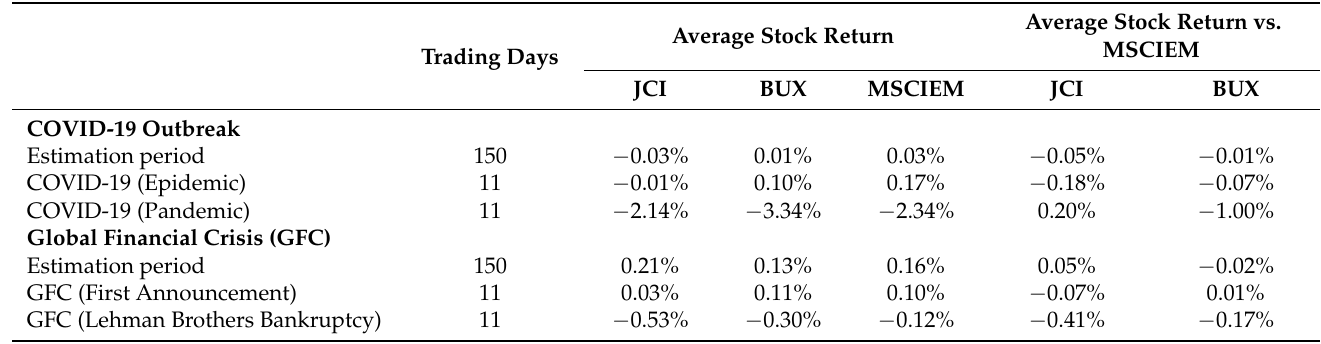
Table 3. The JCI and BUX return relative to MSCIEM.